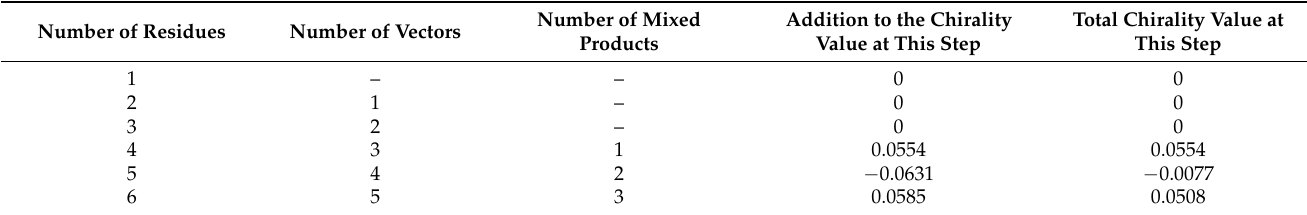
Table 3. Stages of calculating the chirality value of the Ω -loop, 2ACT protein (residues 8–13) [100]. Number of